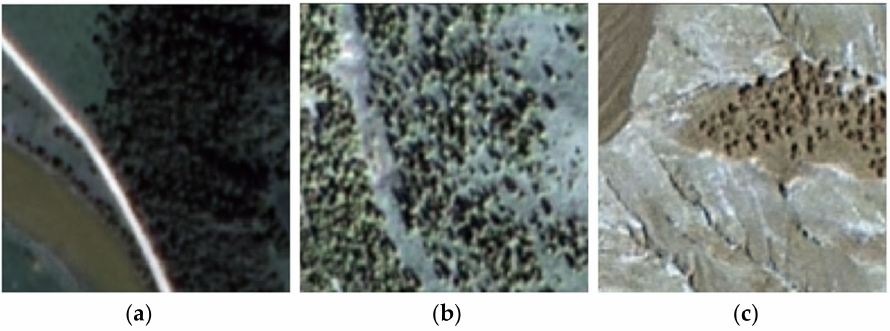
Figure 1. Different types of forest community located in Sanjiangyuan National Nature Re- serve: ( a ) high-density forest community, ( b ) medium-density forest community, ( c ) low-density forest community.